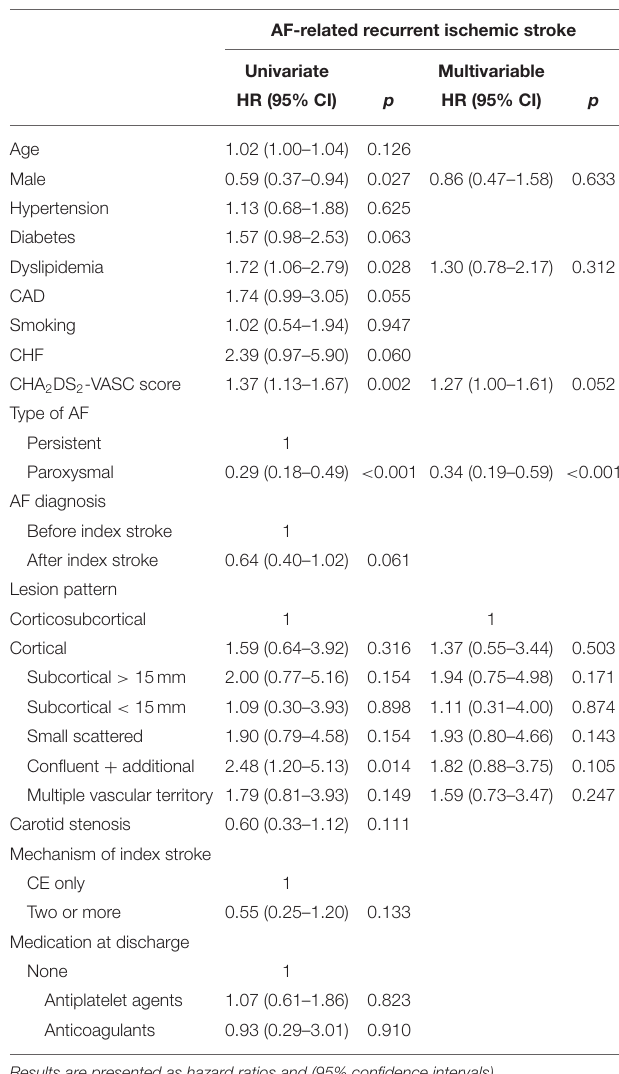
TABLE 2 | Univariable and multivariable analyses of factors predictive of AF-related stroke recurrence. AF-related recurrent ischemic